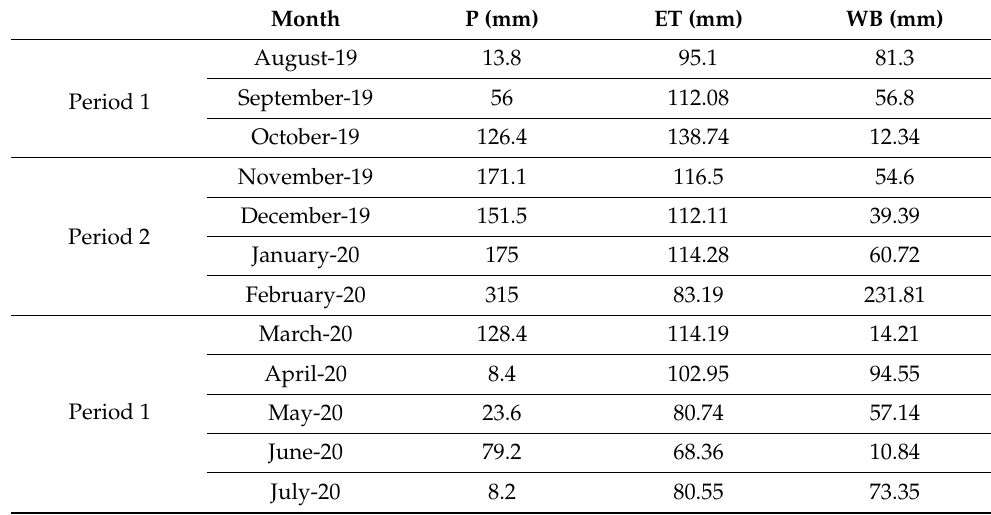
Table 3. Precipitation (P), Evapotranspiration (ET), and Water Balance